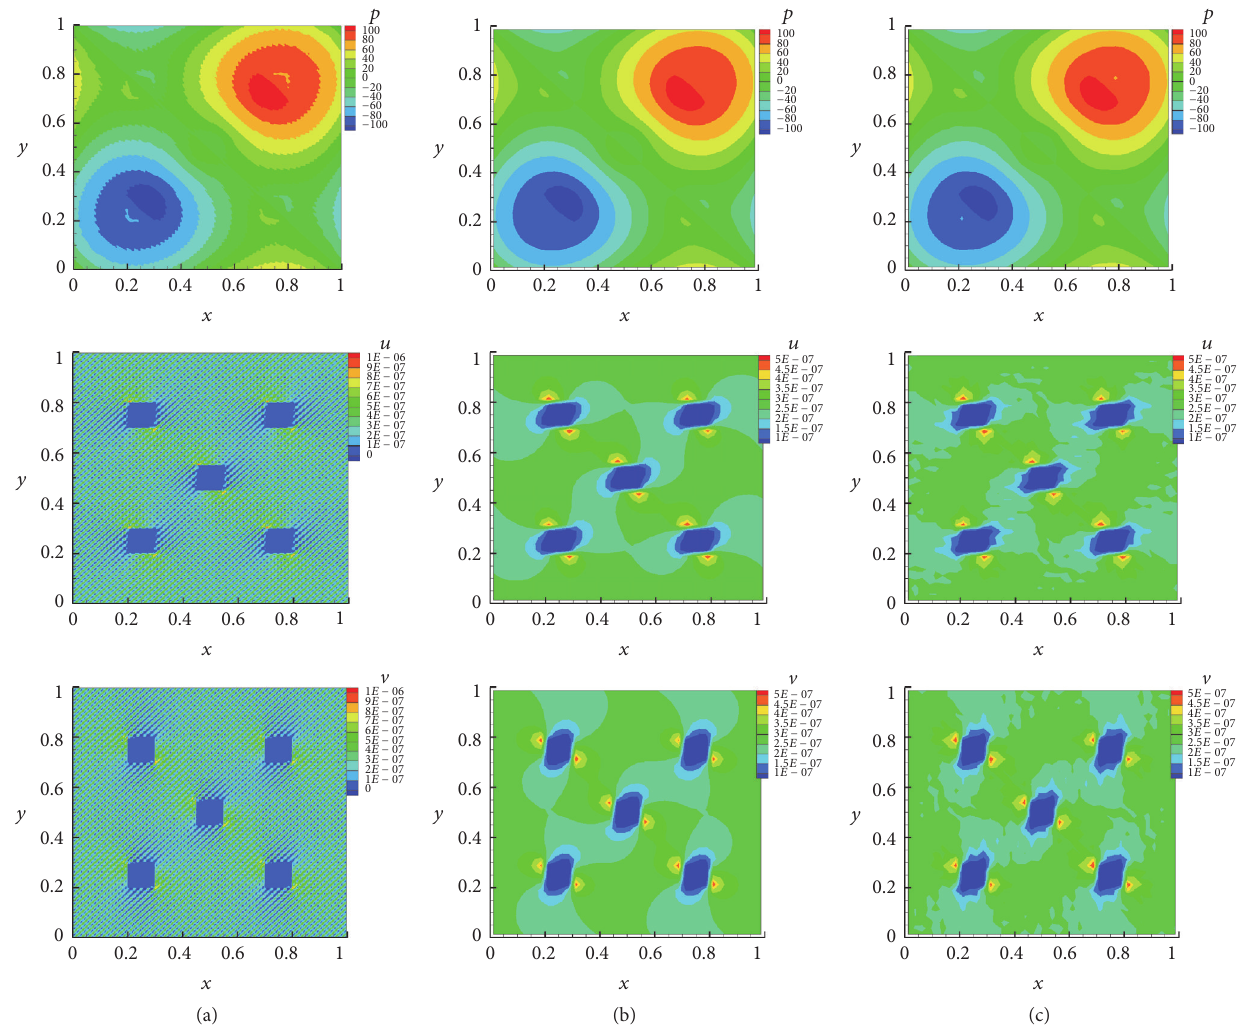
Figure 5: Comparisons of 𝑝 , 𝑢 , and V between the fine-grid results (a), fine-grid averaged results (b), and coarse-grid results using 𝜅 ∗ (c), = 0 m 2 s −1 , ⃗𝐺 = ( sin 𝜋𝑥, sin 𝜋𝑦) m s −2 , and 𝜅 ] eff